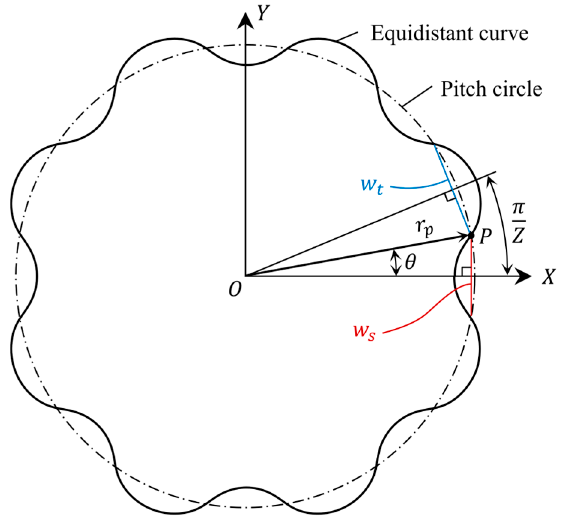
Figure 3. Tooth thickness ratio